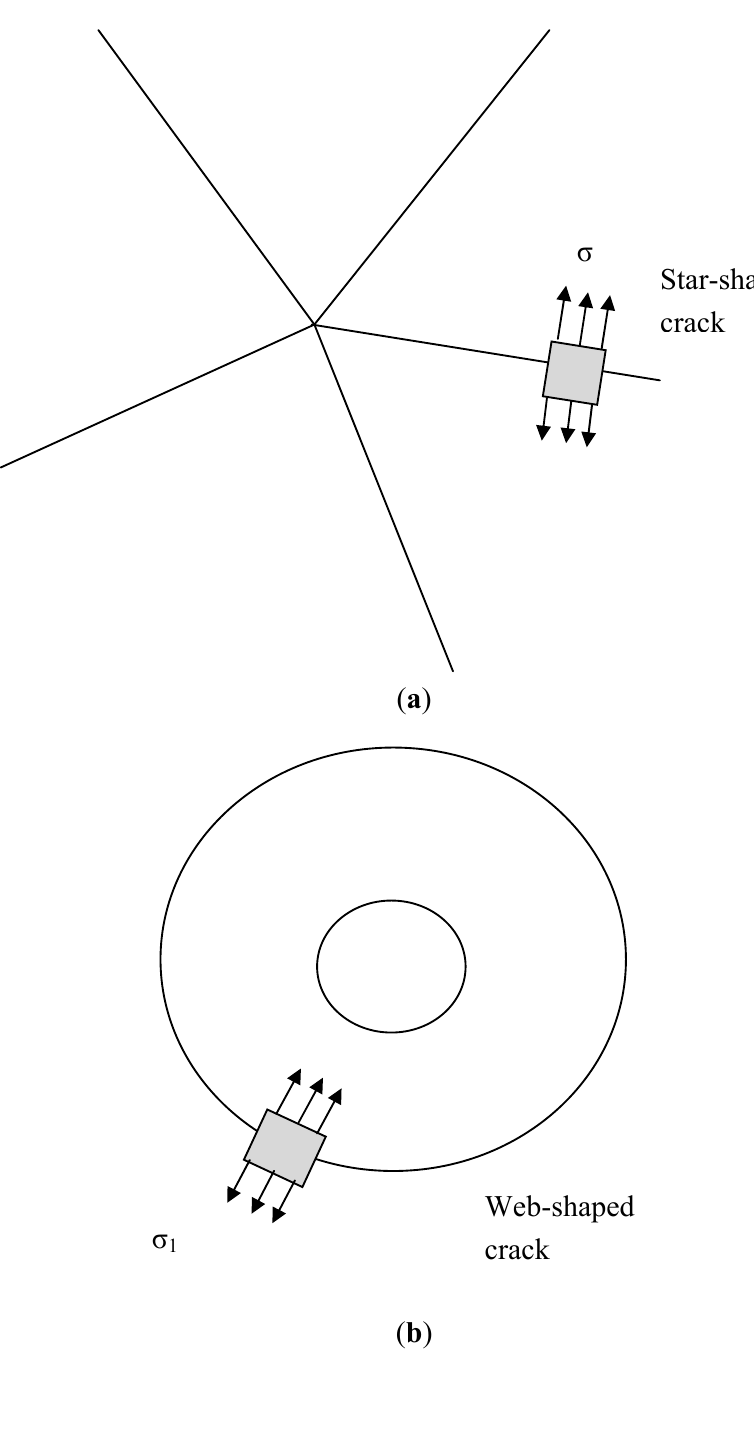
Figure 3. Schematic of crack patterns on the glass surface and the corresponding causal stresses ( a ) star-shaped crack; ( b ) web-shaped